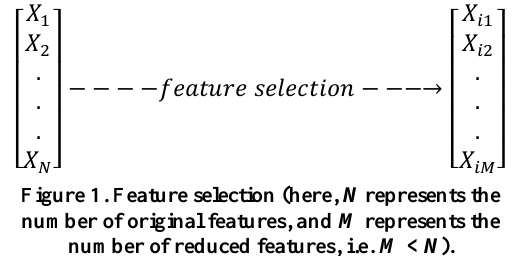
Figure 1. Feature selection (here, N represents the number of original features, and M represents the number of reduced features, i.e. M < N